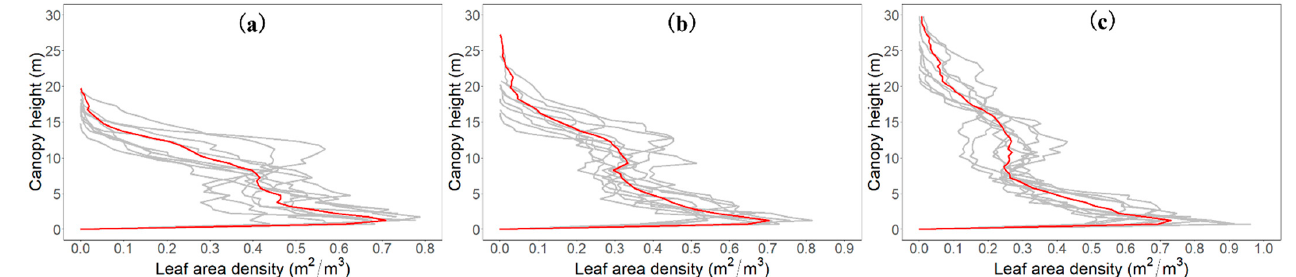
Figure 8. The vertical LAD profile of the nine plots for the Intermediate ( a ), Transition II ( b ), and Late successional stage ( c ). The solid red line in each subfigure is the average for the corresponding nine waveforms.